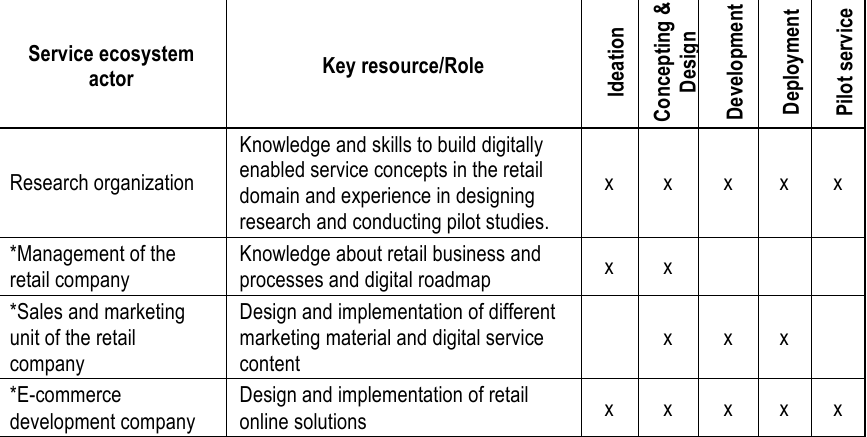
Table 3. Ecosystem actors, their key resources/roles and participation in the innovation process (*) part of the service provider